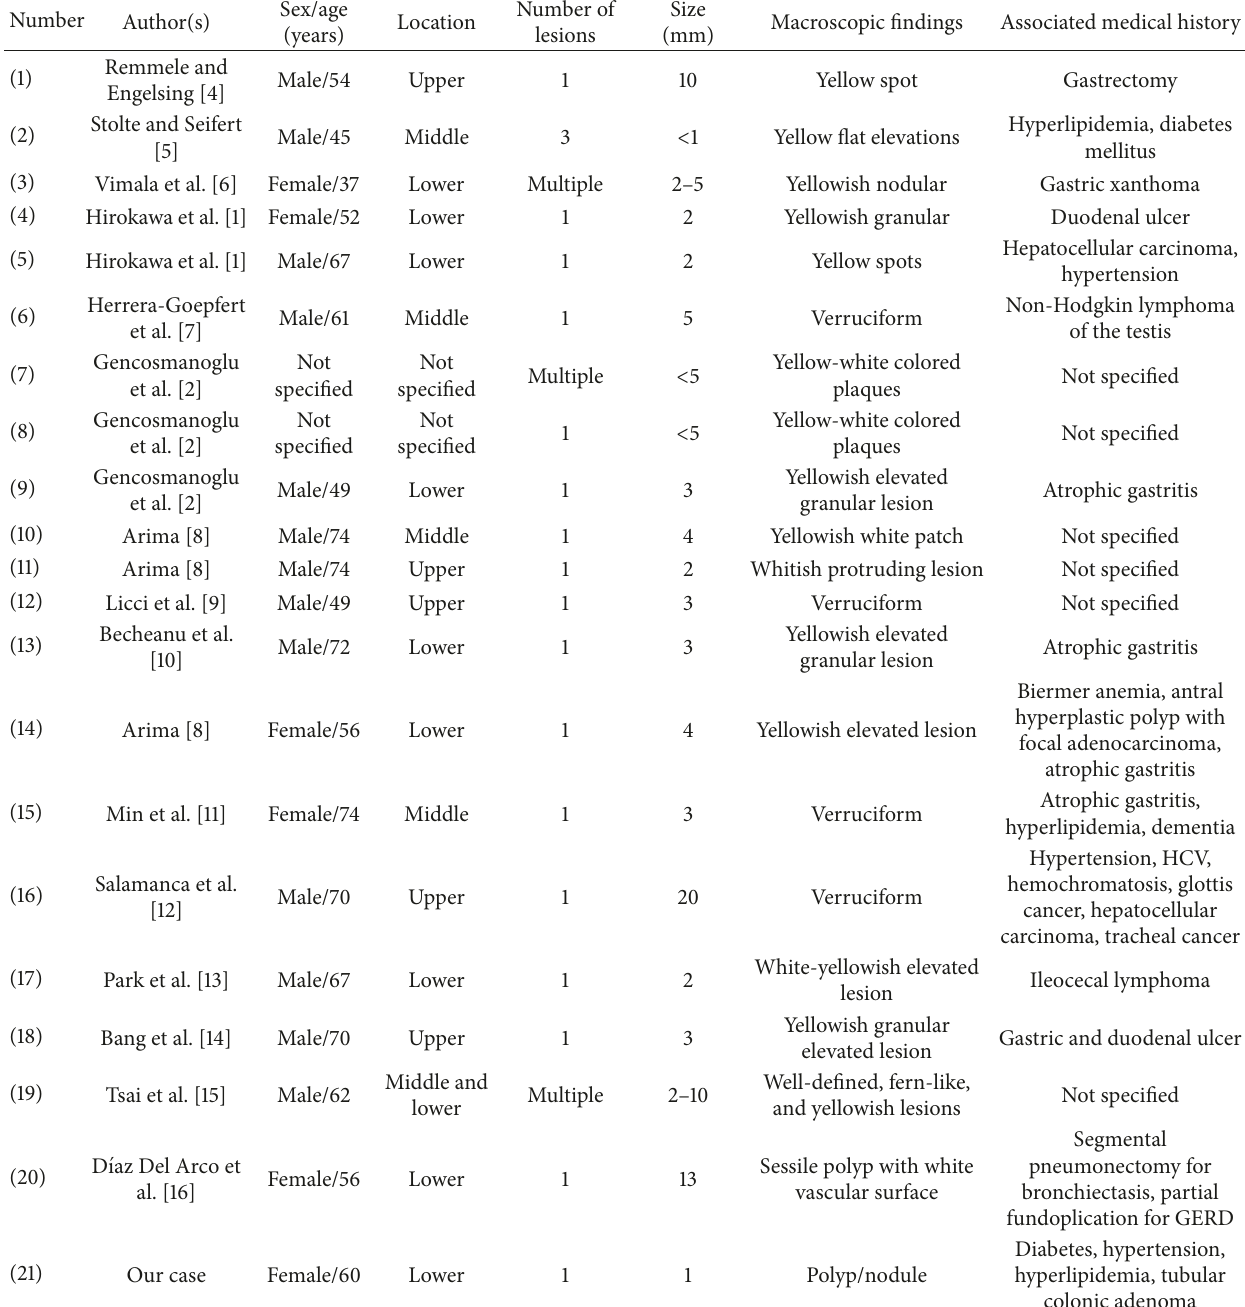
Table 1: Characteristics of reported esophageal